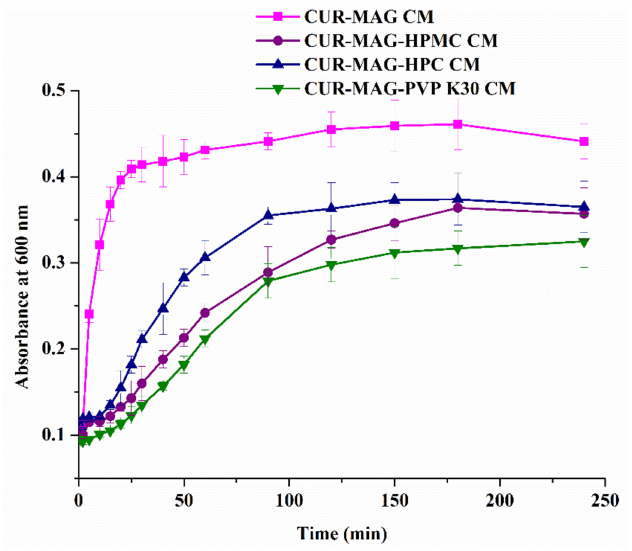
Figure 10. Nucleation inhibitory effect on CUR and MAG by polymer in